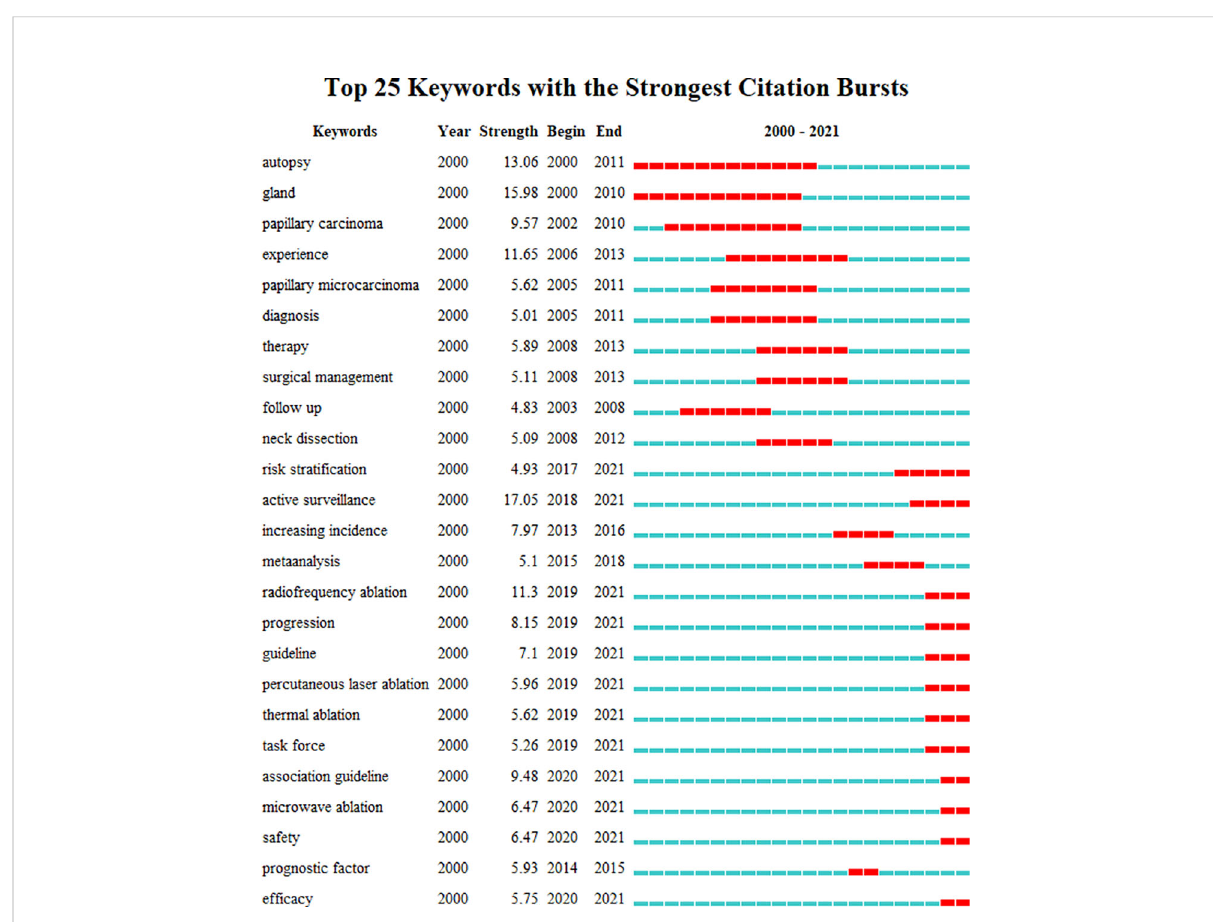
FIGURE 7 Top 25 keywords with the strongest citation bursts. Keywords with the strongest citation bursts in the scienti fi c literature were analyzed and visualized in the keyword ’ s bursts map. Each short line represented a year and lines in red stood for the burst detection years. Keywords with red lines extend to the last year can indicate the research frontiers in a short period of time in the